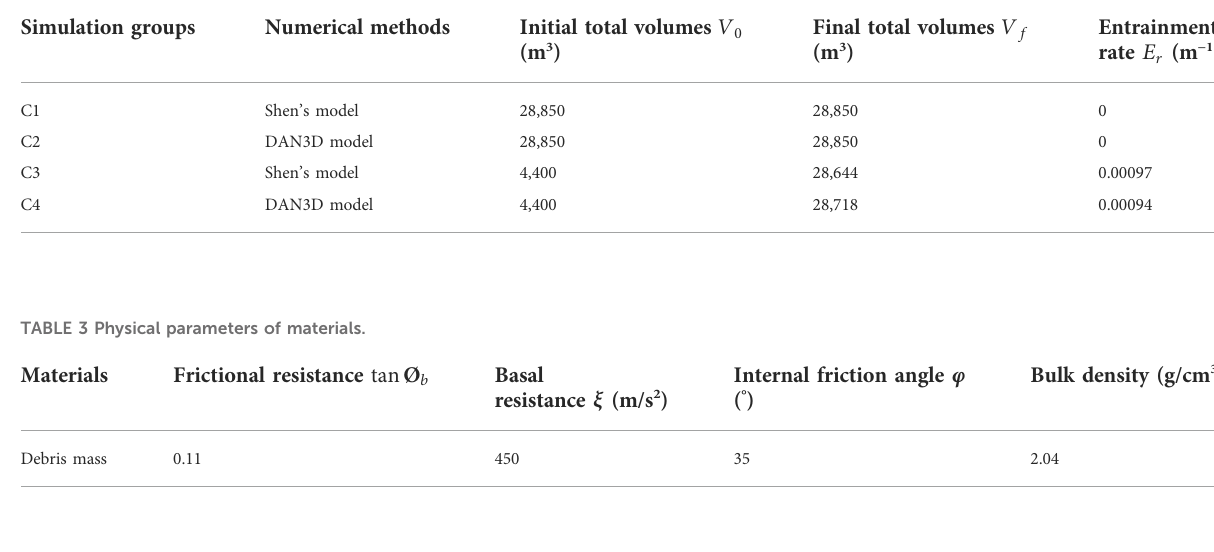
TABLE 2 Setups in different simulation groups.